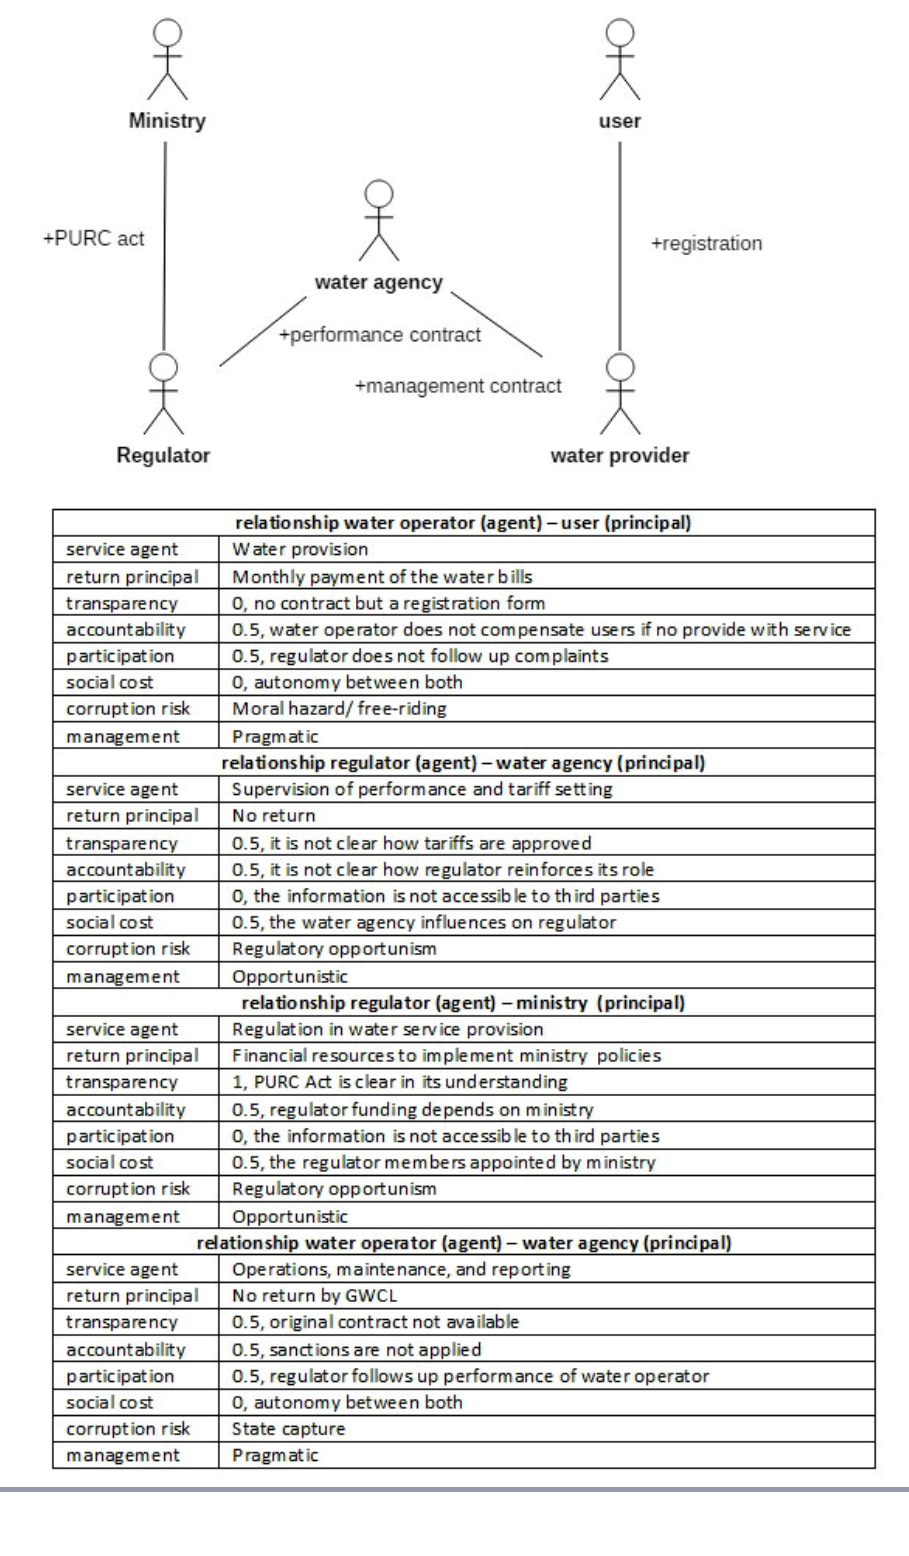
Fig. 2 . Main actors involved in water service delivery (WSD) in Ghana. Note: GWCL = Ghana Water Company